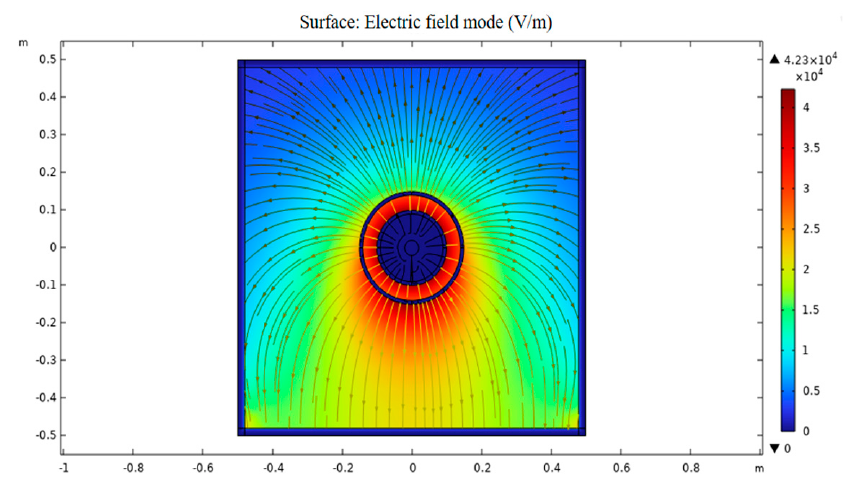
Figure 6. Electric field simulation diagram.